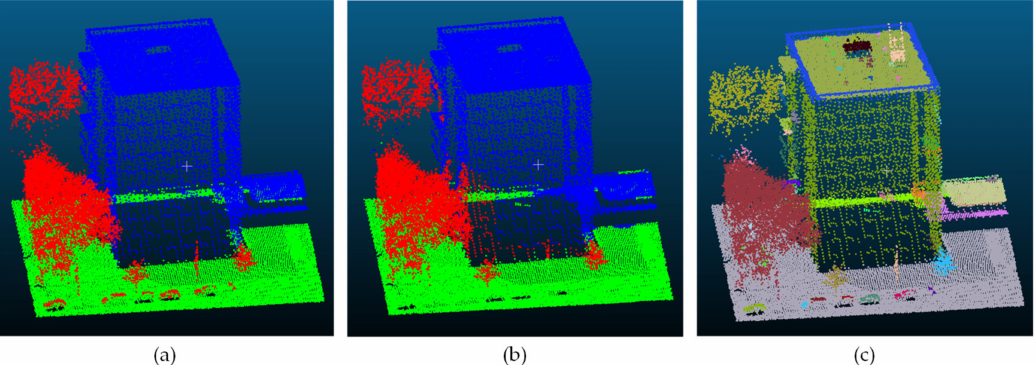
Figure 11. ( a ) Prediction result by our framework in the testing area; ( b ) Prediction result by Pointnet ++ in the testing area; ( c ) The segmentation result. Building, navy blue; tree, red; and terrain,